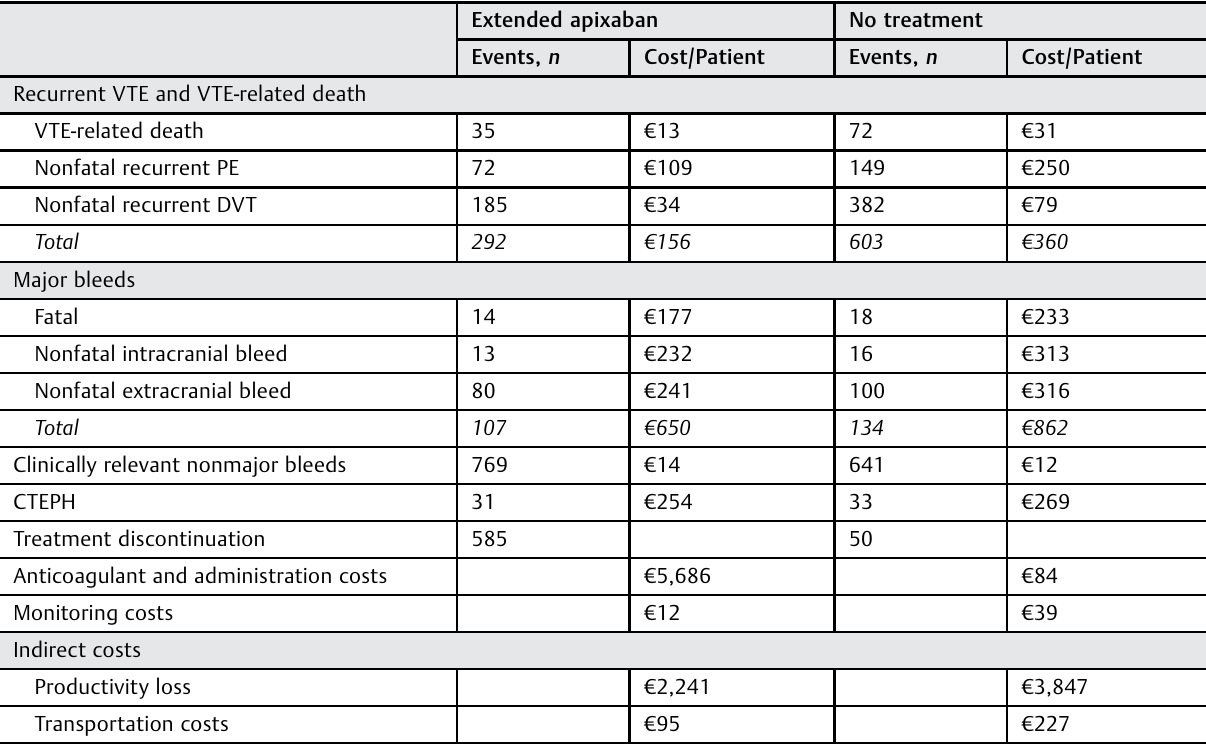
VTE patients: the base-case